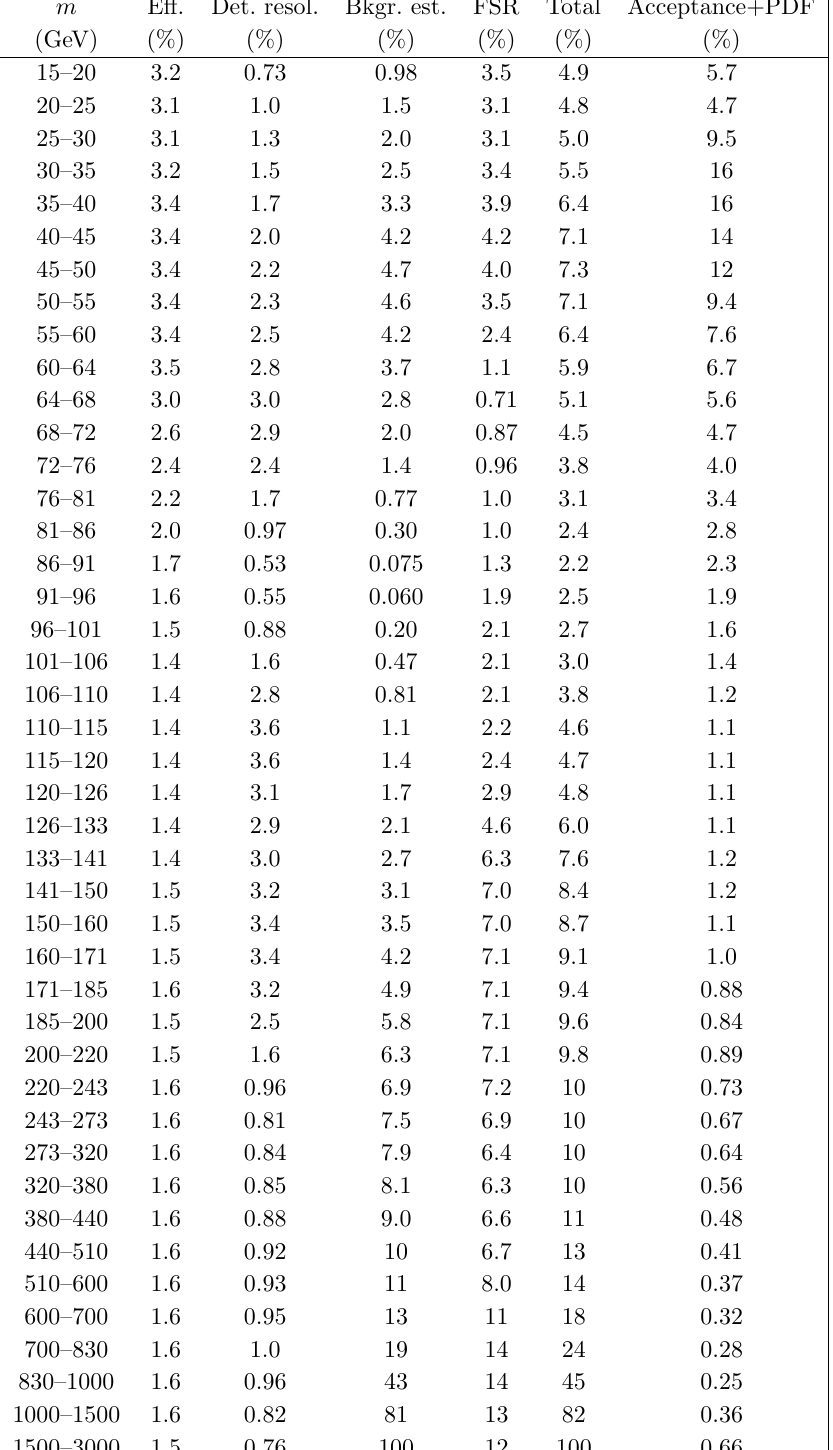
Table 2 . Summary of the systematic uncertainties (%) for the d (cid:27)= d m (pb/GeV) measurement in the dielectron channel. The column labelled \Total" corresponds to the quadratic sum of all the experimental sources, except for that